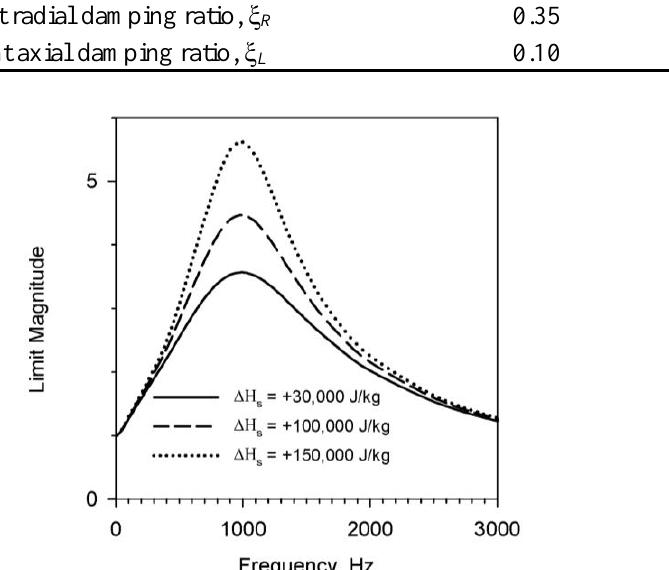
Figure 3. Frequency response of the reference propellant ( K for Δ H ; r = 1.27 cm/s) in terms of the non-dimensional limit s b,o